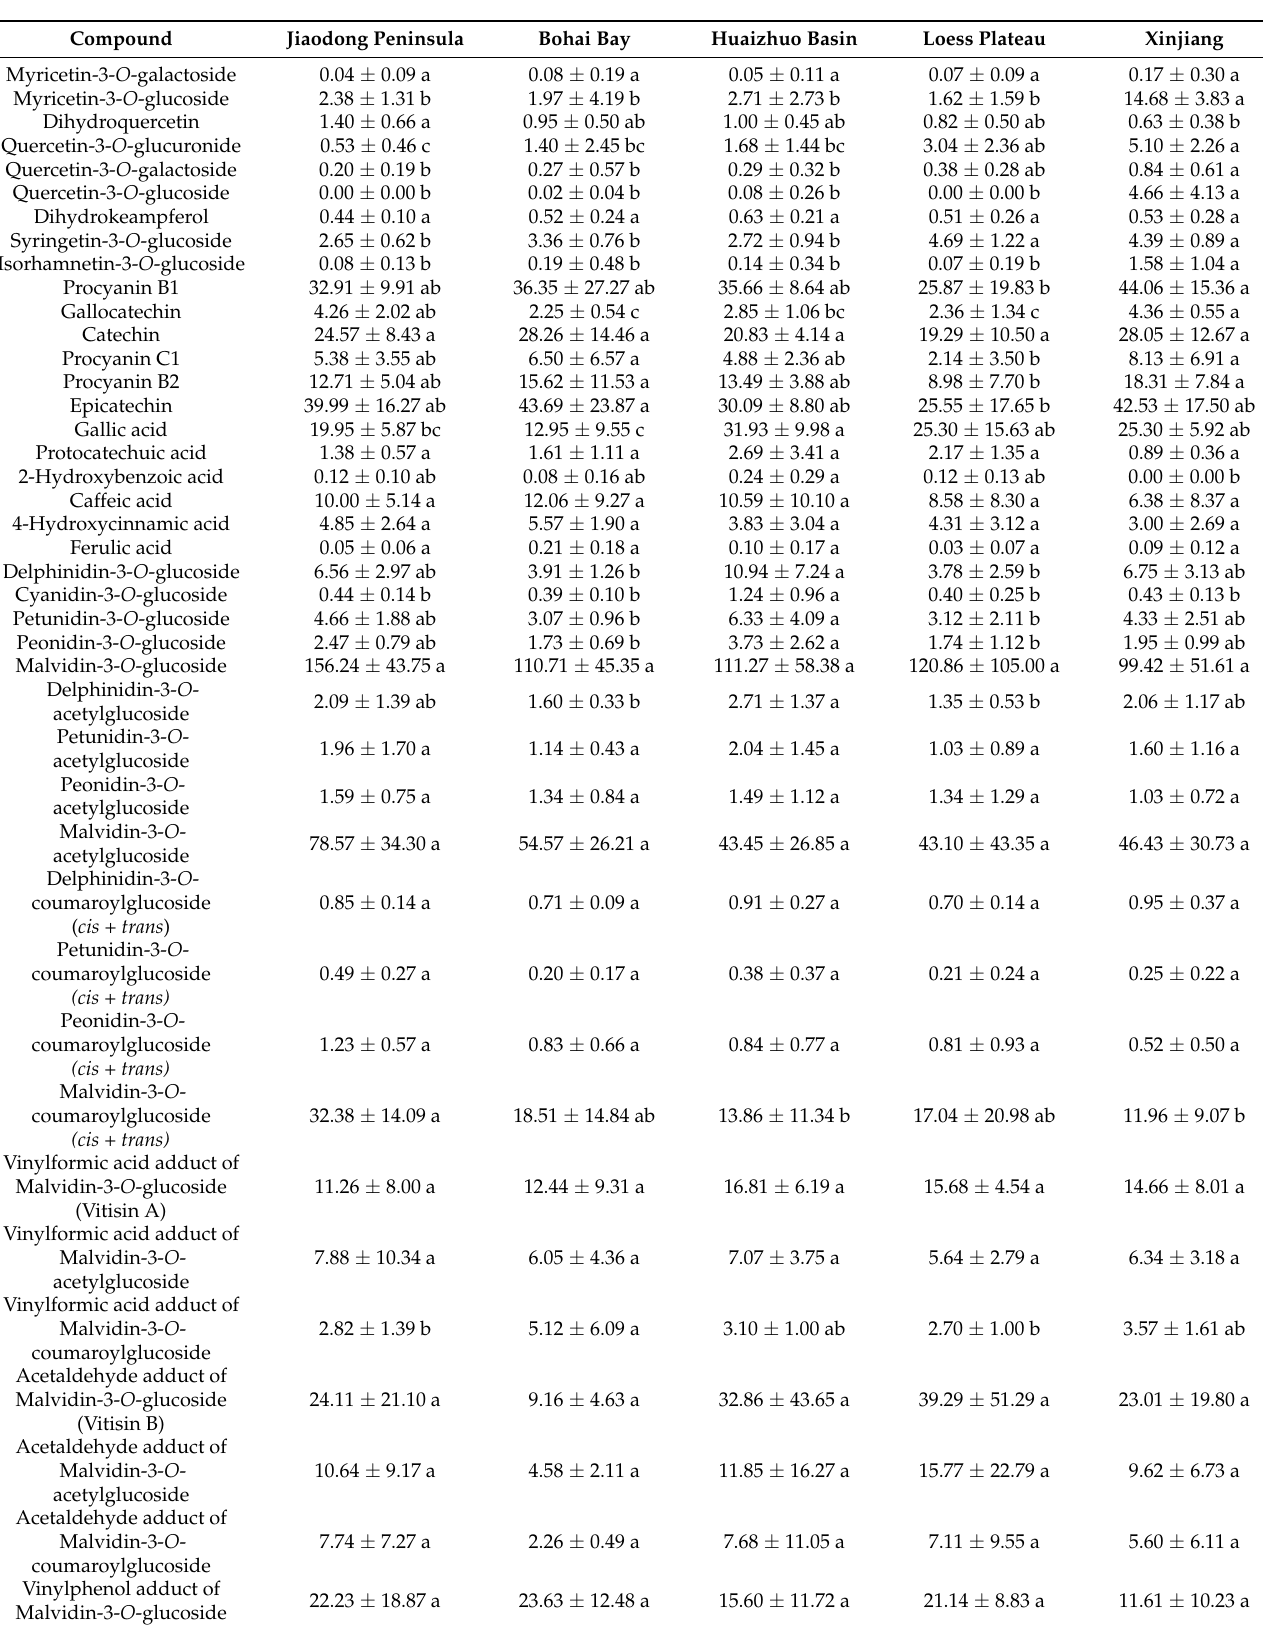
Table 4. Concentrations of the phenolic compounds of Marselan wines from different regions of China